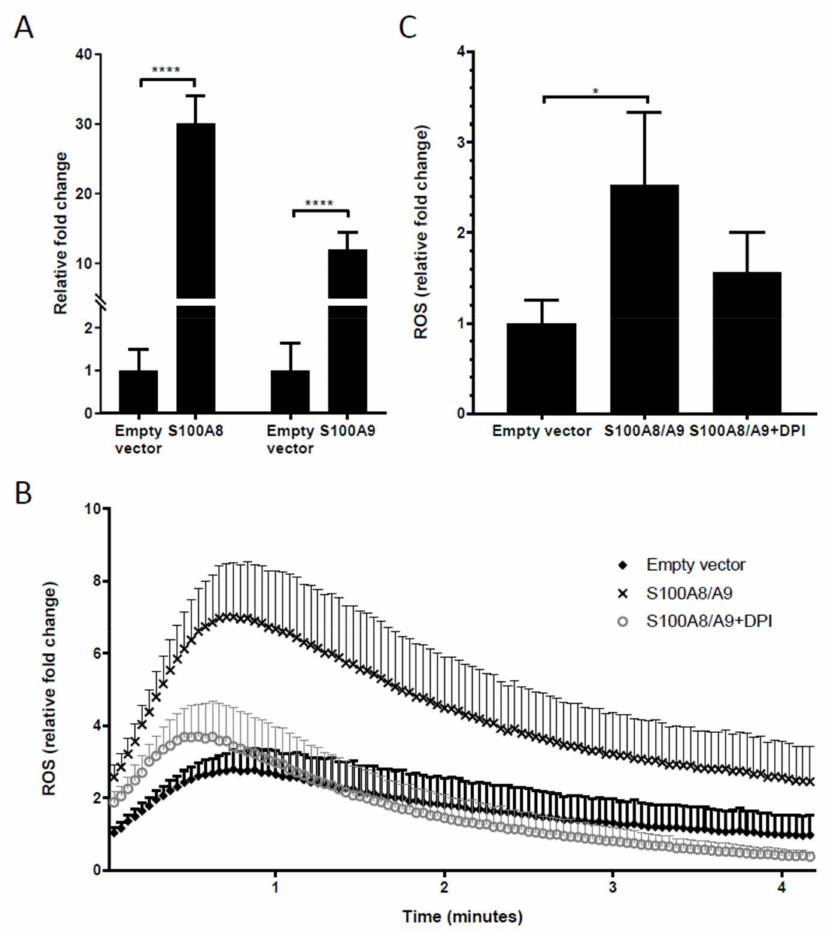
Figure 4. Overexpression of S100A8/A9 in monocyte-derived macrophage increases reactive oxygen species (ROS) production. ( A ) The mRNA level in monocyte-derived macrophages after transfection was significantly higher than that in the empty plasmid control. The differences were tested by t -tests; ( B ) After phorbol 12-myristate 13-acetate (PMA) activation, the transfected cells were placed immediately in a luminometer to measure their ROS production real-time every 2.5 s. Data are expressed as means ± SEM of at least four different experiments; ( C ) The peak of ROS production, assessed at the tenth timepoint (25 s) was significantly higher in the S100A8/A9-overexpressed macrophages compared to cells transfected with the empty plasmid. Inhibition of NADPH oxidase activity by diphenylene iodonium (DPI) blocked the ROS production. The differences were tested by one-way ANOVA with Tukey’s multiple comparison tests. All data are expressed as means ± SD of at four different experiments. * p < 0.05, **** p <